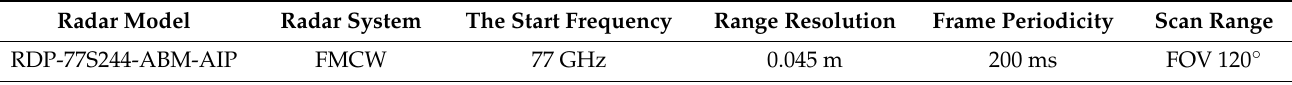
Table 2. MIMO radar